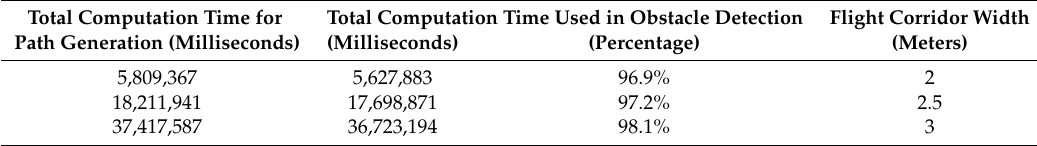
Table 2. Preliminary inspection of the bottleneck. In this table are shown the computation times involved in generating a path. Firstly, the total time used to find a path is shown. The total time can be decomposed in time spent on obstacle detection and the remaining time. The second column details the computational time needed to detect obstacles, both in milliseconds and as a percentage of the total time. In all flight corridor widths, obstacle detection comprises over 96% of the entire time, exposing the